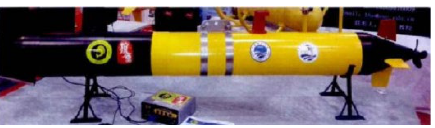
Figure 2. Sailfish underwater vehicle.